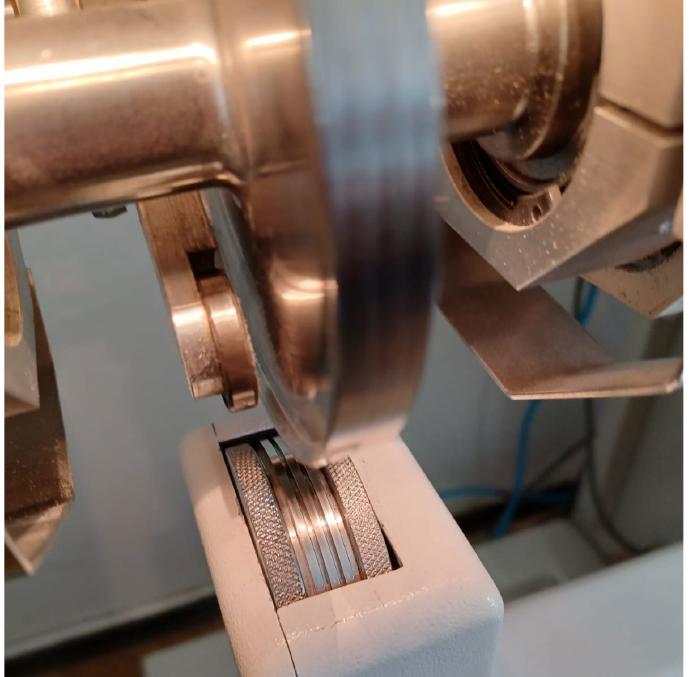
Figure 4. A rotary sonotrode and counter roller for the ultrasonic welding of polymer